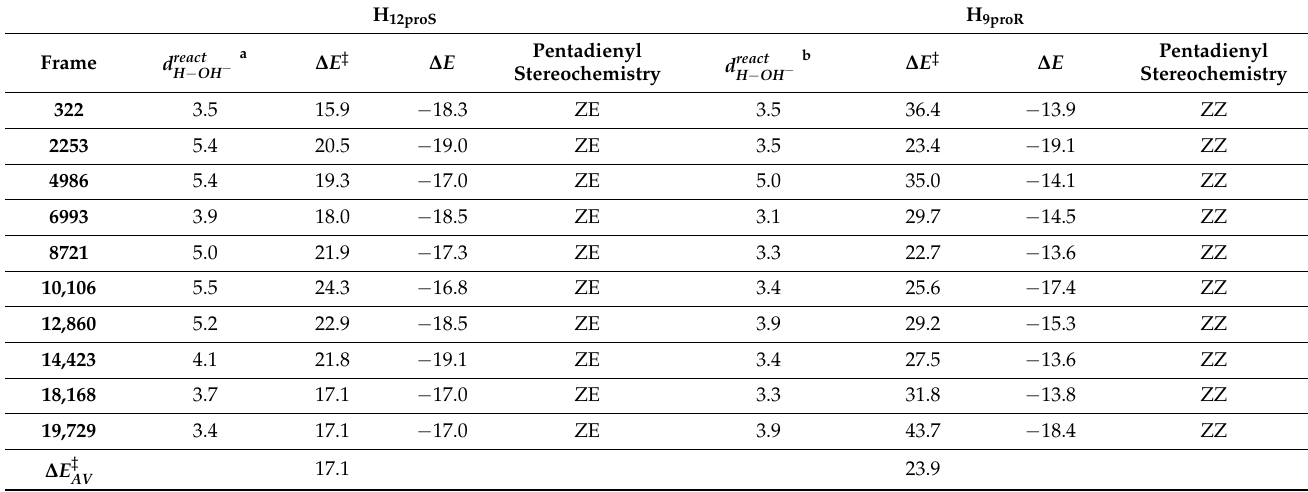
Table 1. Number of the MD frame used as initial coordinates for the QM/MM optimization